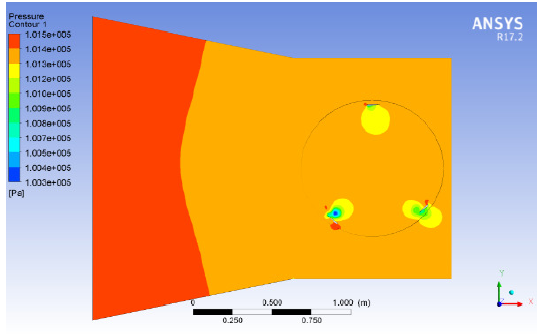
Fig. 8. Velocity distribution along convergent duct inlet angle 20 . °